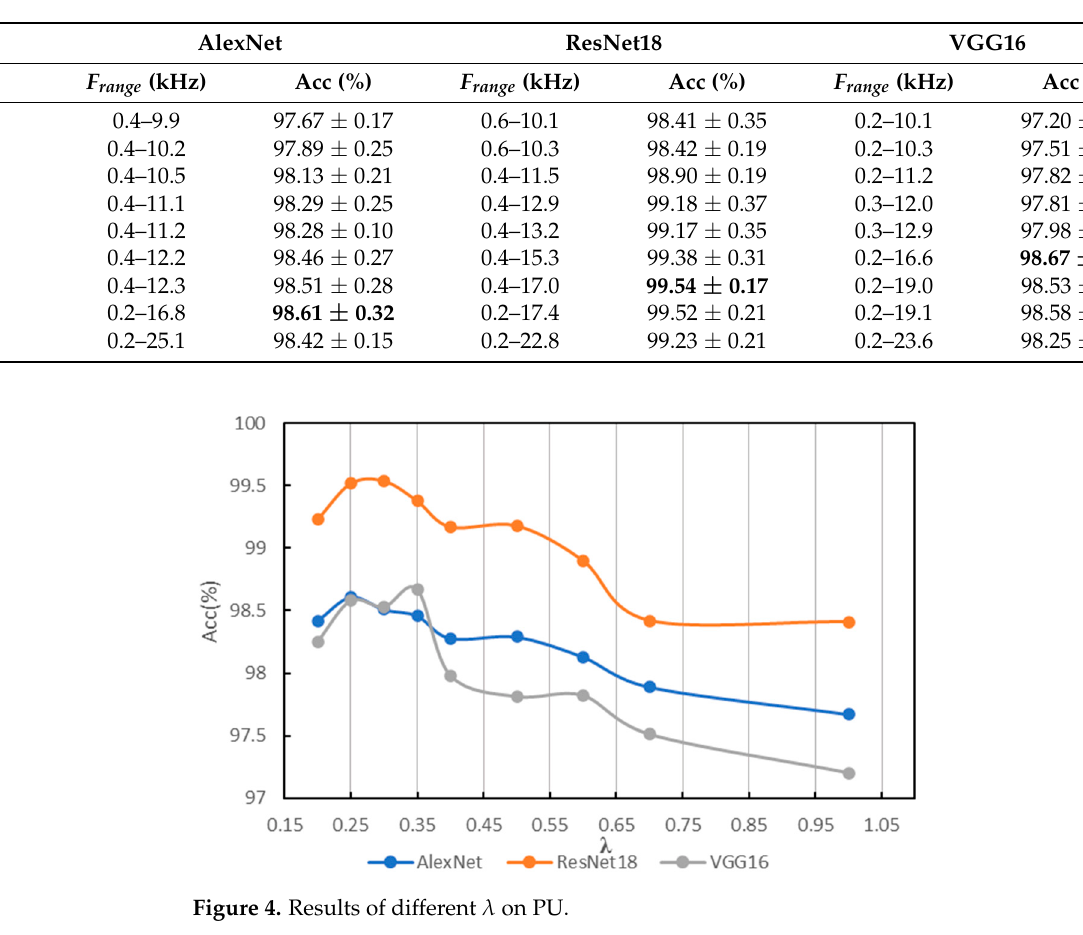
Table 1. Results of different λ on PU.